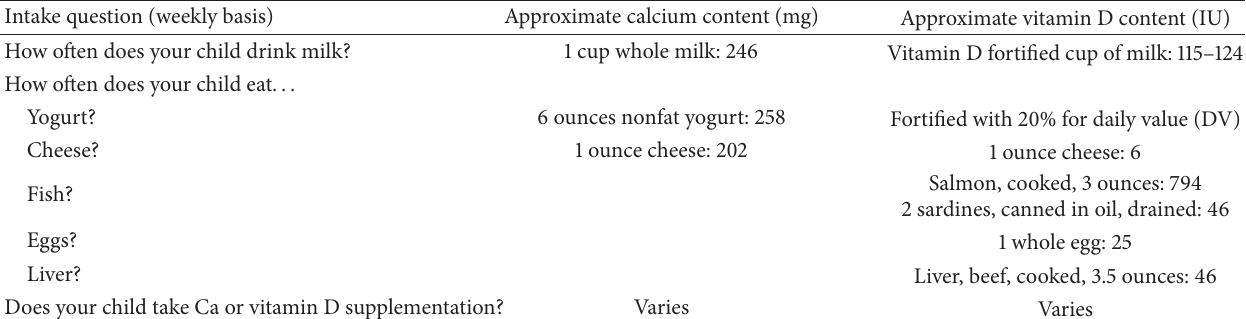
Table 1: Calcium and vitamin D intake